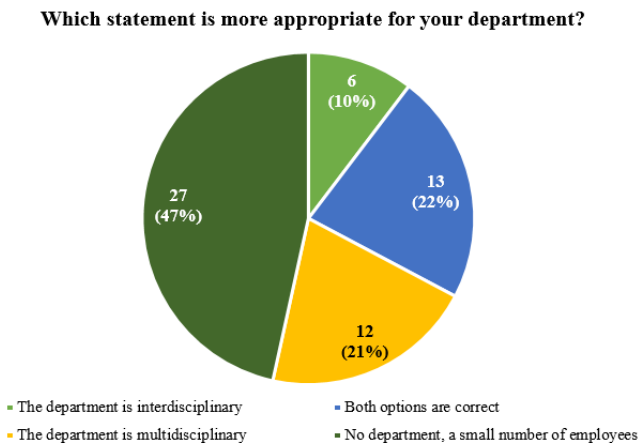
Figure 3. The types of BIM departments.